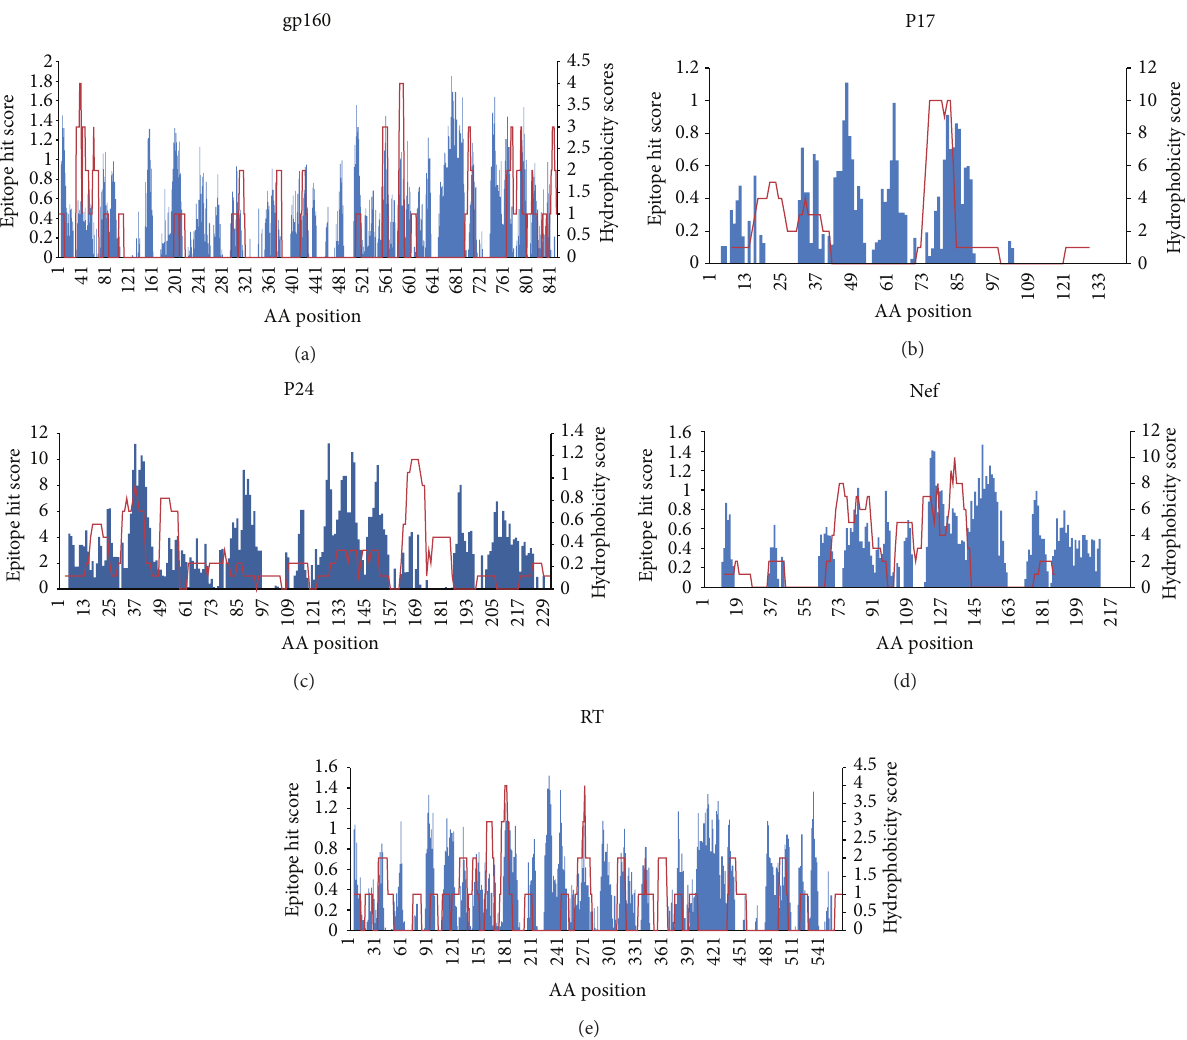
Figure 4: Epitope clusters and hydrophobic pattern of five HIV proteins. The 𝑋 -axis represents the amino acid position. The primary 𝑌 -axis (left) shows the hydrophobicity scores whereas the secondary 𝑌 -axis (right) represents the epitope hit/count values. The blue bars indicate the hydrophobicity score whereas the red line represents the epitope hit values. For the hydrophobicity scores, the negative values were not shown in the figure, and only the scores greater than 0 were